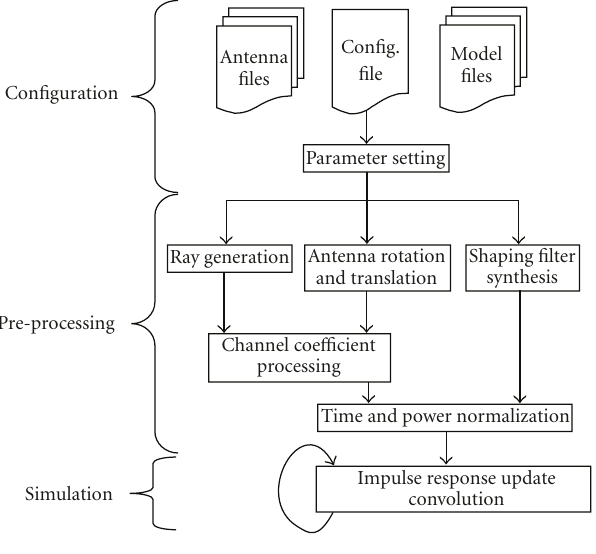
Figure 11: Mascaraa block diagram.